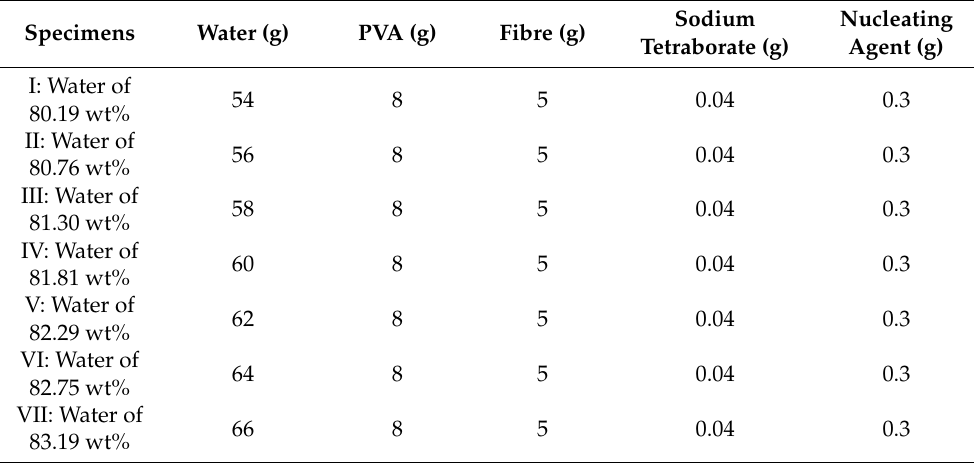
Table 3. Formulations of the composites with different water